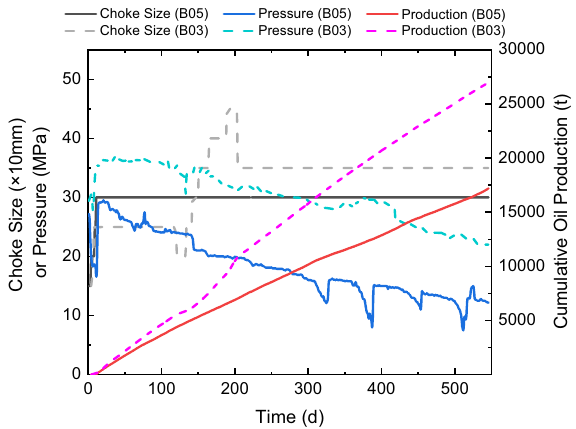
Figure 10. Production curves of comparison wells in the Ma-18 play.